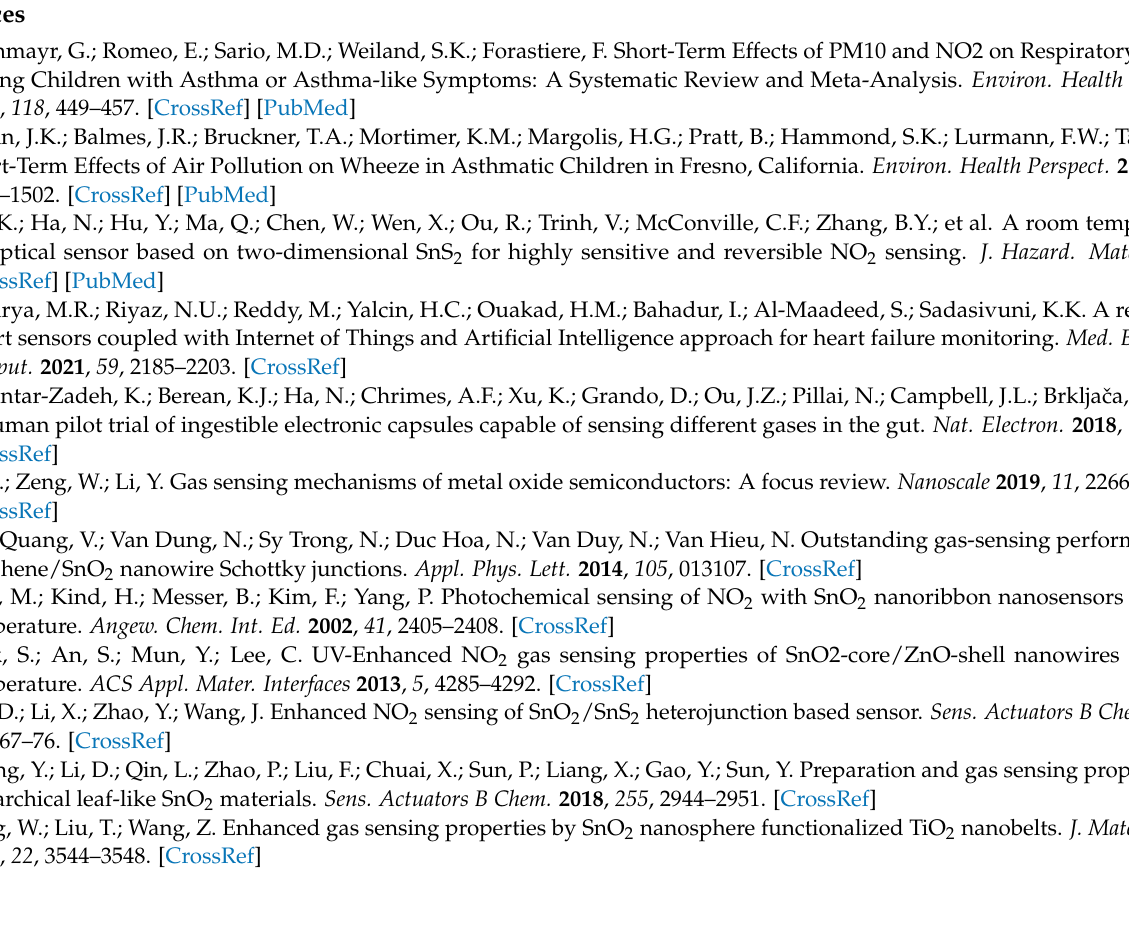
week, Figure S4: (a) Low resolution TEM and (b) HRTEM images for cobalt oxysulfide taken after long-term stability test, Figure S5: The response curve of cobalt oxysulfide sensor towards 1% H2 in the dry, and 40%